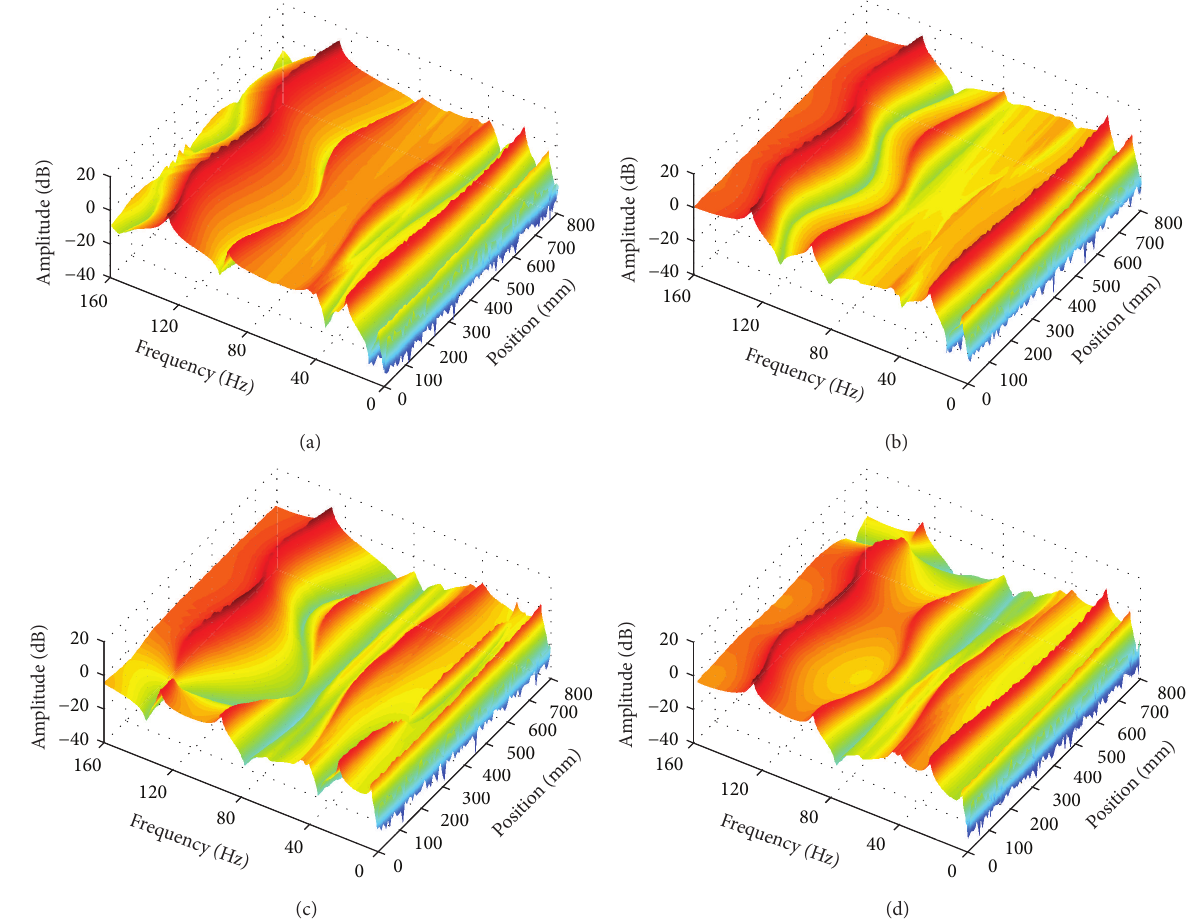
Figure 4: FRFs of the baseline models: (a) 𝐻